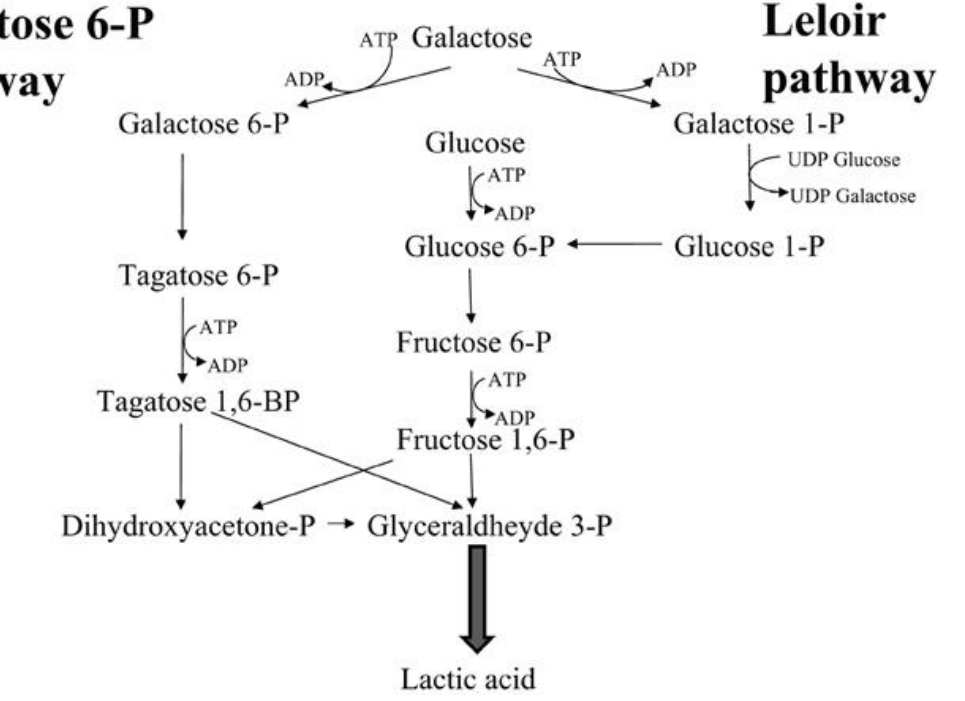
Figure 4. Interconnection between the Leloir and Tagatose-6-phosphate pathway in bacterial galactose metabolism. Adapted with permission from Pessione, [143]).